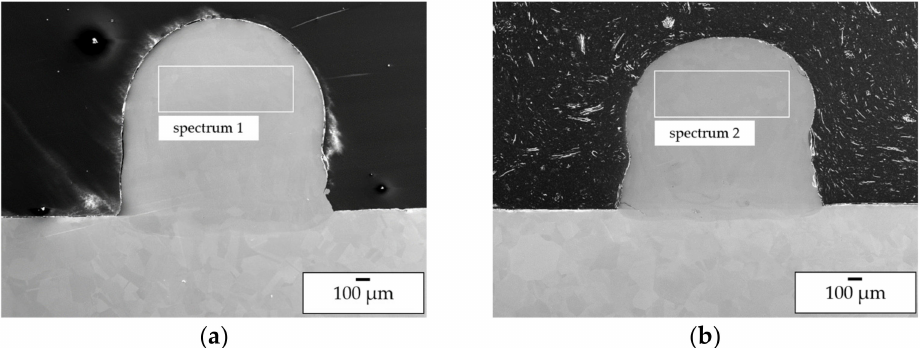
Figure 15. SEM BSE images of wall specimens consisting of three tracks manufactured using pre-alloyed powder ( a ) and in situ alloying ( b